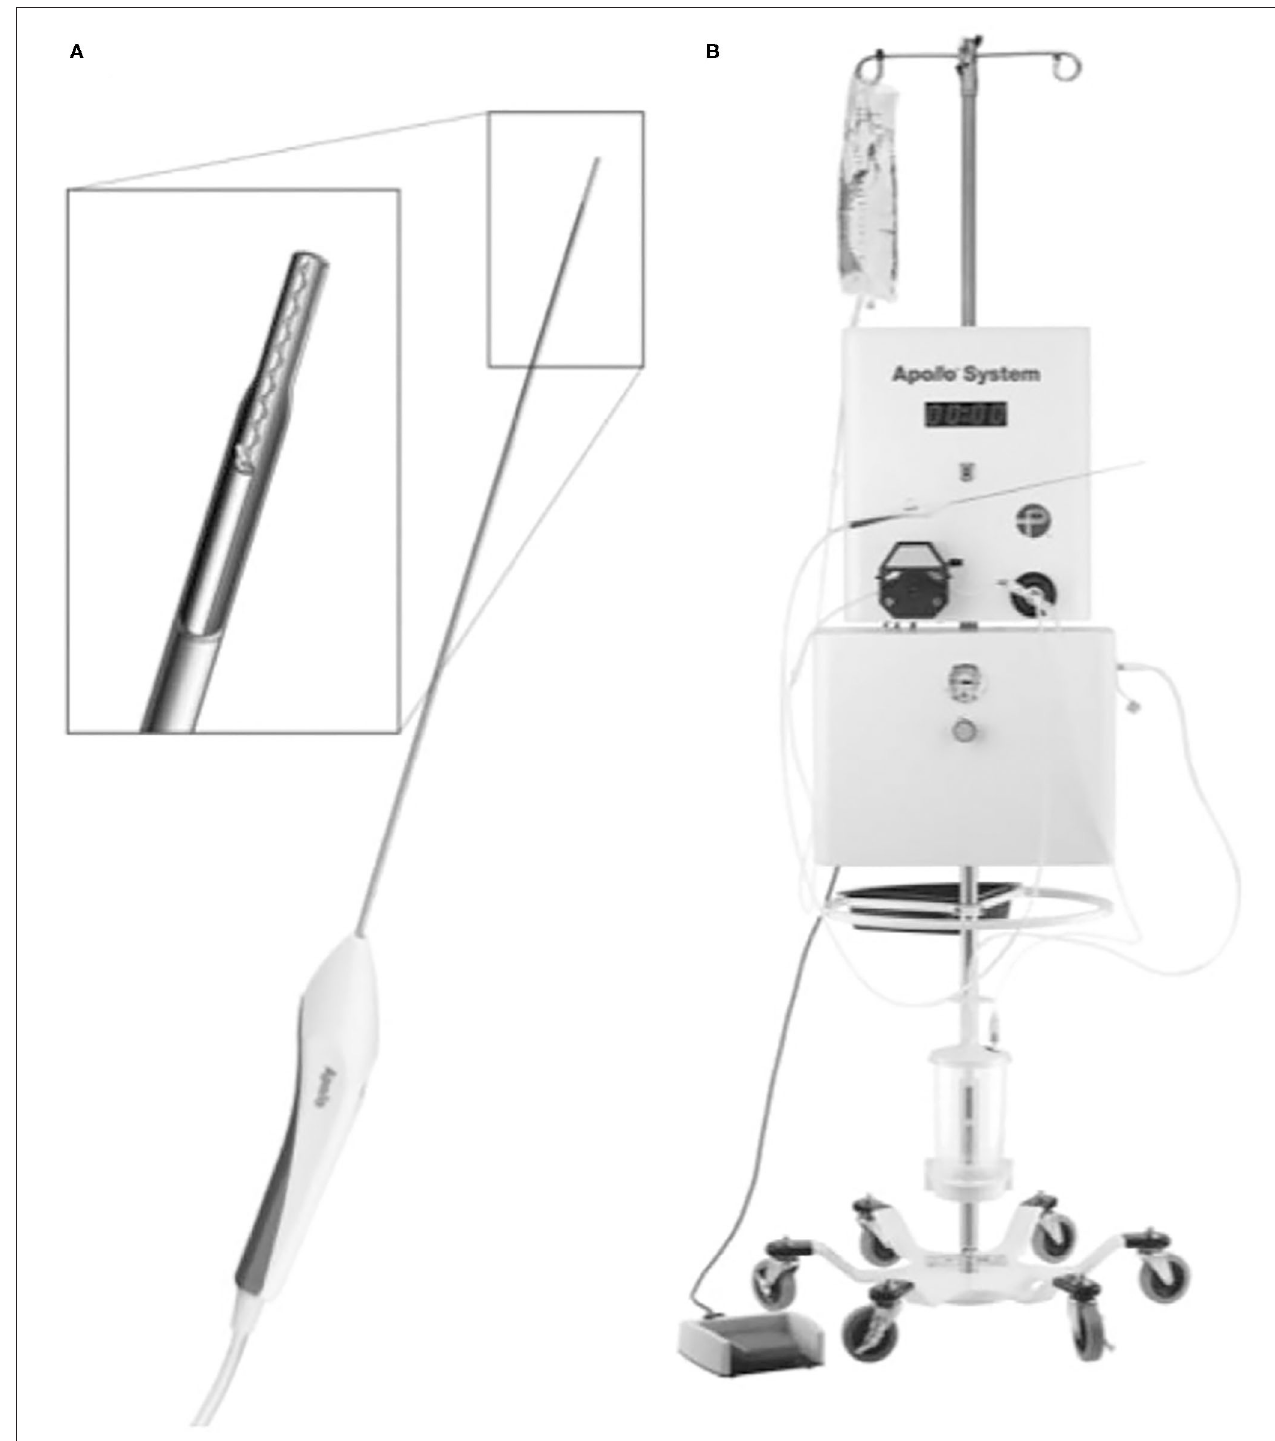
FIGURE 4 | The Apollo System consists of a suction-irrigation system that can be connected to the Apollo wand through a soft tube. The wand (A) can be placed through the working channel of a neuroendoscope. The wand is equipped with an internal stirrer line that vibrates at ultrasonic frequency and impregnates the clot material to keep the system unobstructed during suction. The wand is connected to a stand-alone suction-irrigation system (B) [from Fiorella et al. (45) with permission].